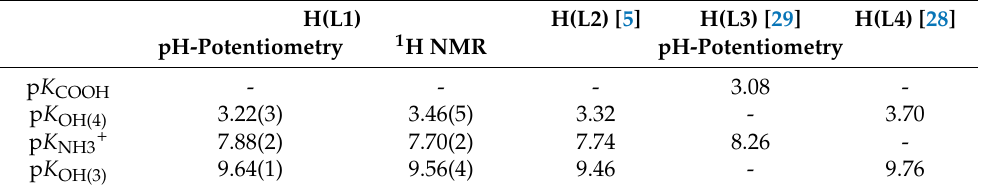
Table 1. Proton dissociation constants (p K a ) of H(L1) and some model ligands at t = 25.0 ◦ C